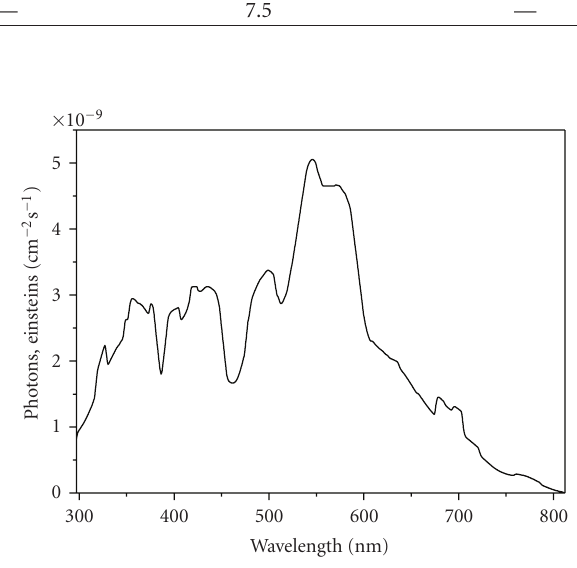
Figure 7: Spectral distribution of the radiation emitted by a 400 W HPL-N mercury lamp in the 295 to 815 nm spectral